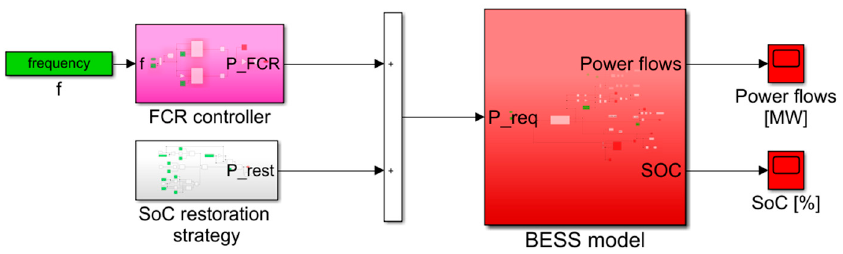
Figure 2. Simplified block diagram of the Simulink tool for the FCR provided by BESS.